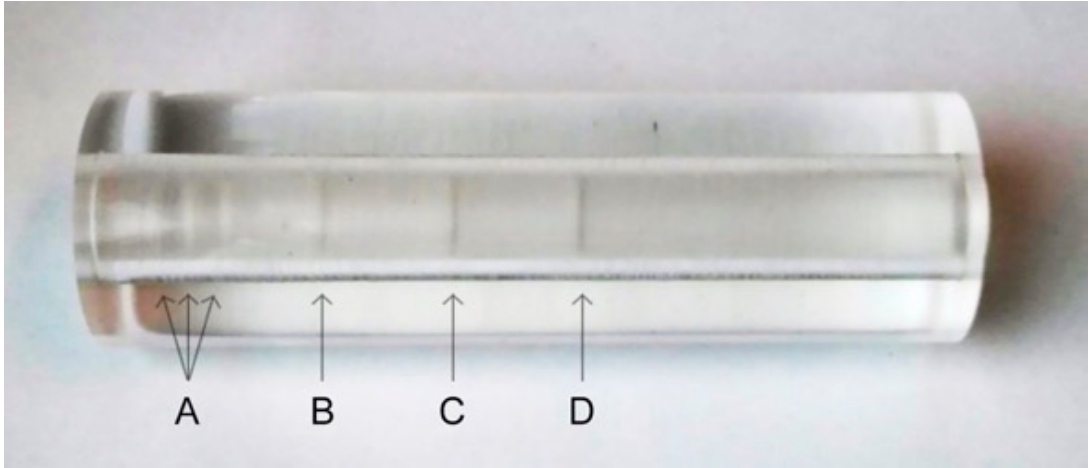
Figure 2. Two-piece acrylic glass mouse phantom (diameter: 3 cm; length: 10 cm). The inner pin (diameter: 1 cm) contains six cavities for one TLD each for measuring the exposure during the µCT scans. Three cavities were placed within 1 cm (head region of the mouse; ( A ) and the others at a distance of 2 cm (lung; ( B )); 3.5 cm (kidney; ( C )) and 5 cm (abdomen; ( D )) from the first cavity.